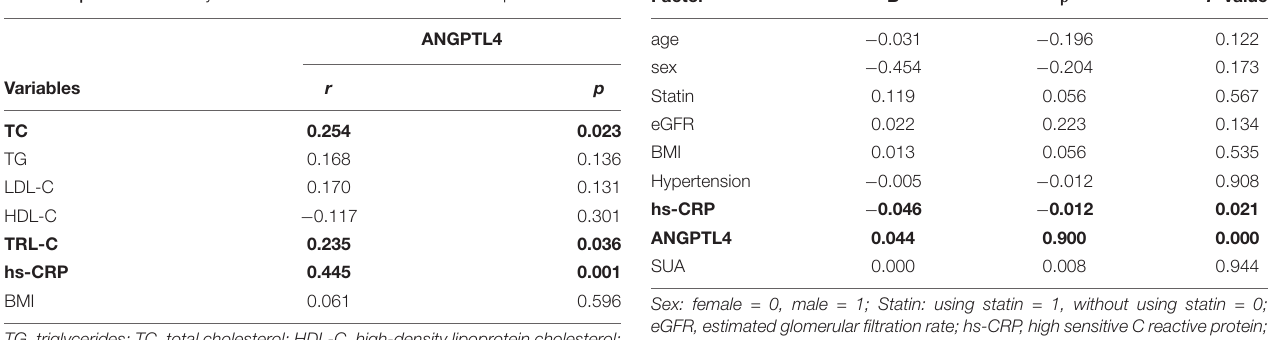
TABLE 4 | Correlation analysis of ANGPTL4 and cardio-metabolic parameters.